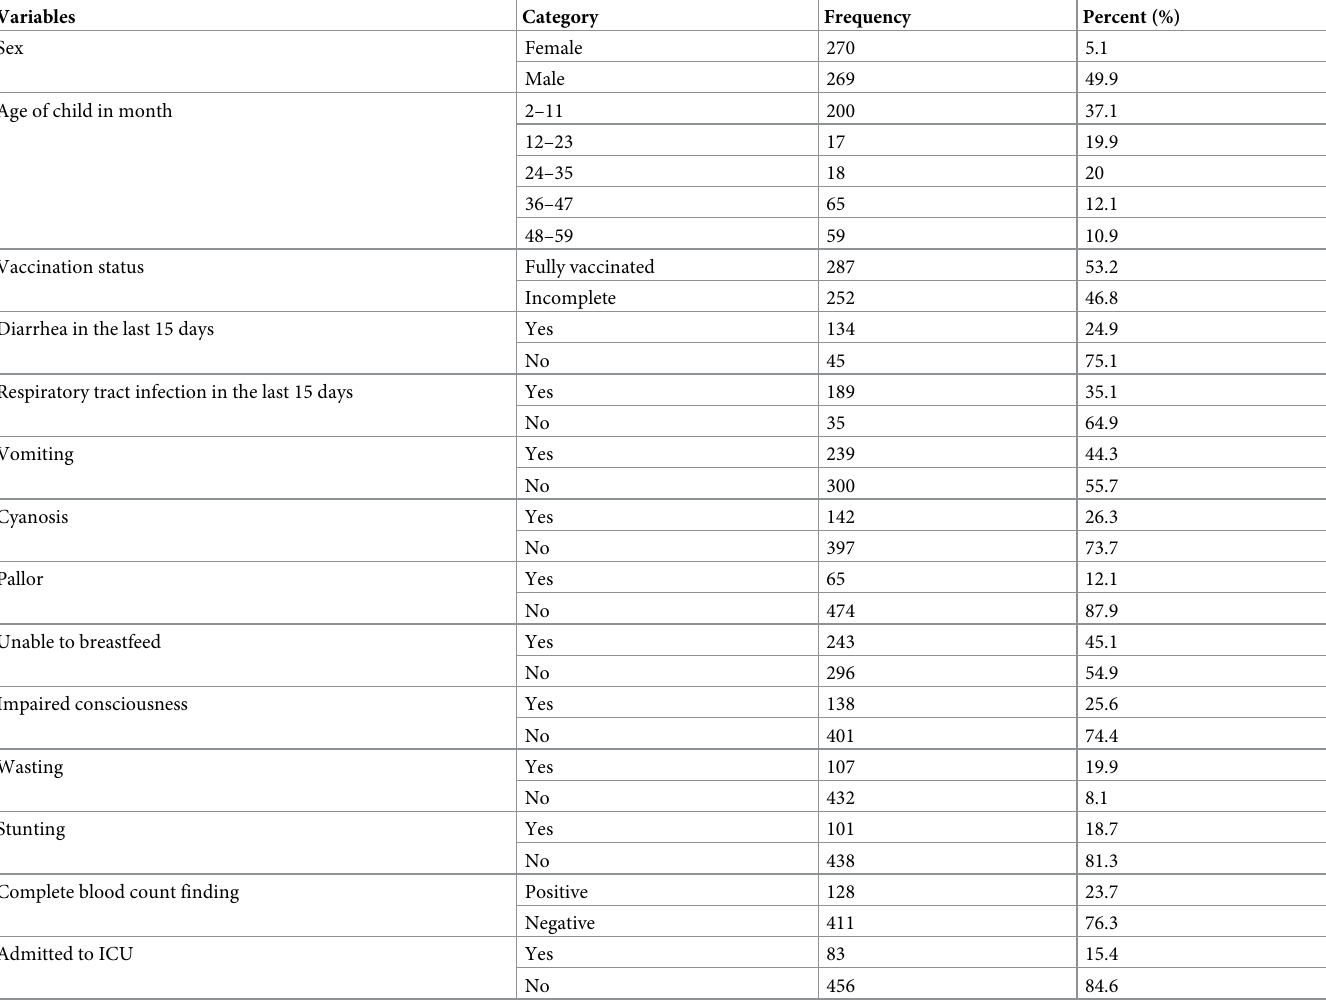
Table 1. Baseline demographic and clinical characteristics of under-five children with pneumonia admitted at hospitals in Amhara region,